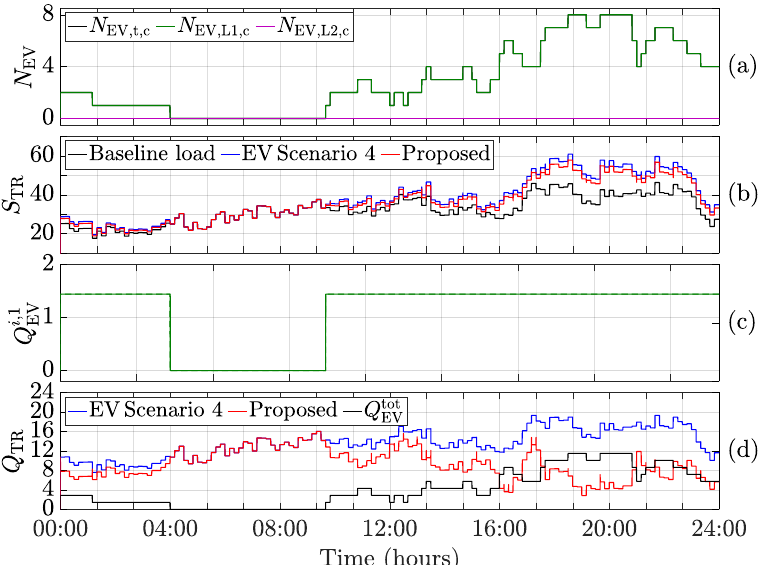
Figure 14. Scenario 4: EV charging overlaps with peak load, ( a ) number of EVs present; ( b ) trans- former apparent power in kVA; ( c ) Q supplied by an online EV at Level 1 in kVAr; ( d ) transformer reactive power in kVAr.